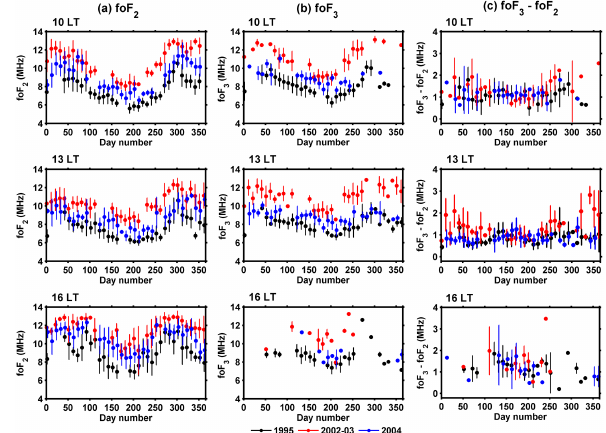
Figure 3. Local time variations of mean and SD of observed f o F2 (blue) and IRI-2012 model f o F2 (black) in different seasons (from top to bottom) in (a) 1995, LSA, (b) 2004, MSA, and (c) 2002– 2003, HSA. Thick black vertical bars in each panel represent the difference of observed f o F2 from IRI-2012 model f o F2 (observed f o F2–IRI-2012 model f o F2).